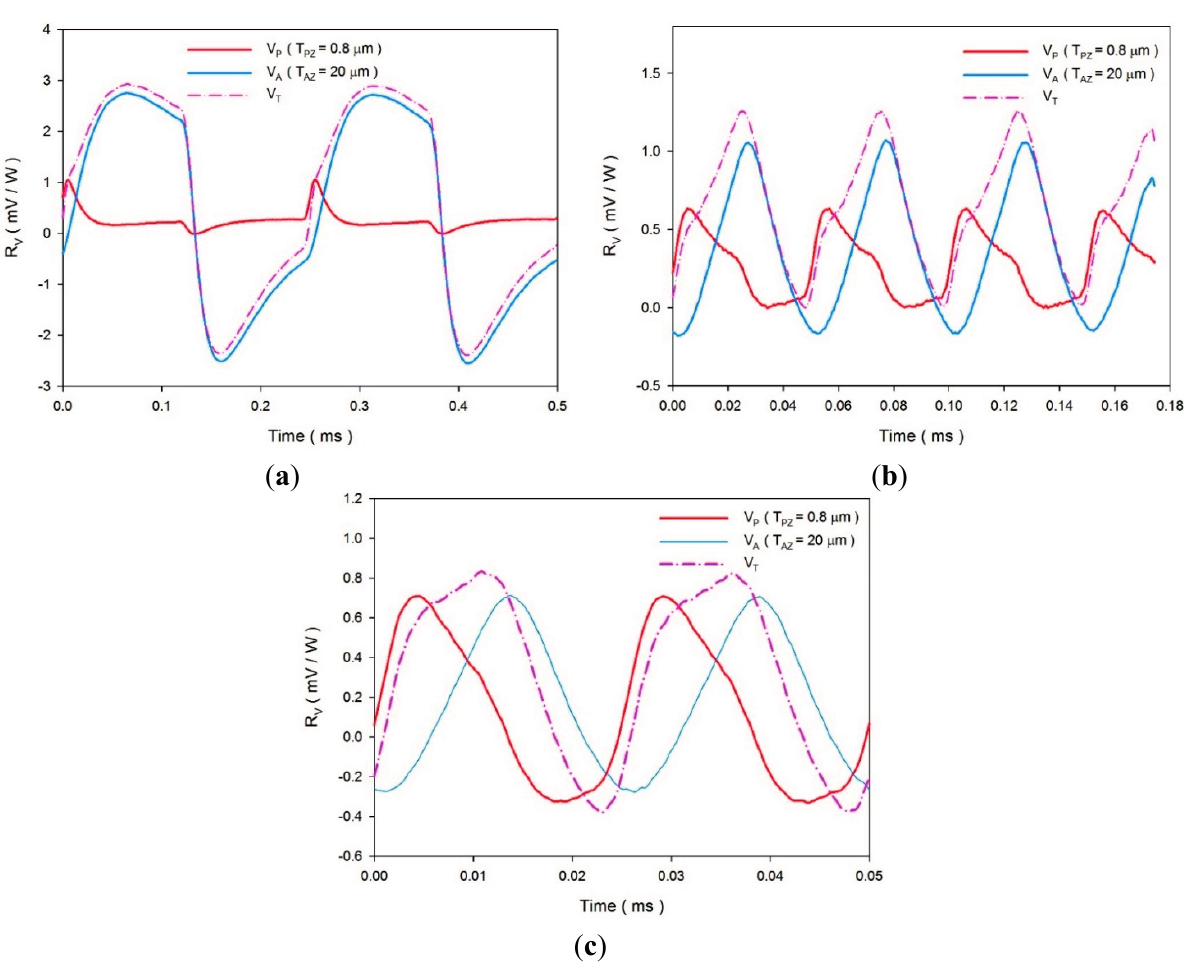
Figure 15. Voltage responsivities of the fabricated multi-frequency band pyroelectric device with T PZ = 1 μ m and T AZ = 20 μ m under the incident irradiation power modulated with various chopping frequencies of about ( a ) 4000 Hz; ( b ) 20,000 Hz and ( c ) 40,000